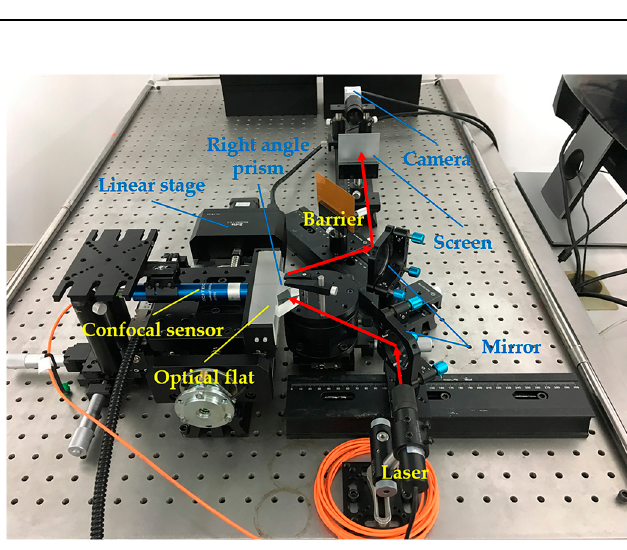
Figure 11. The experimental platform.